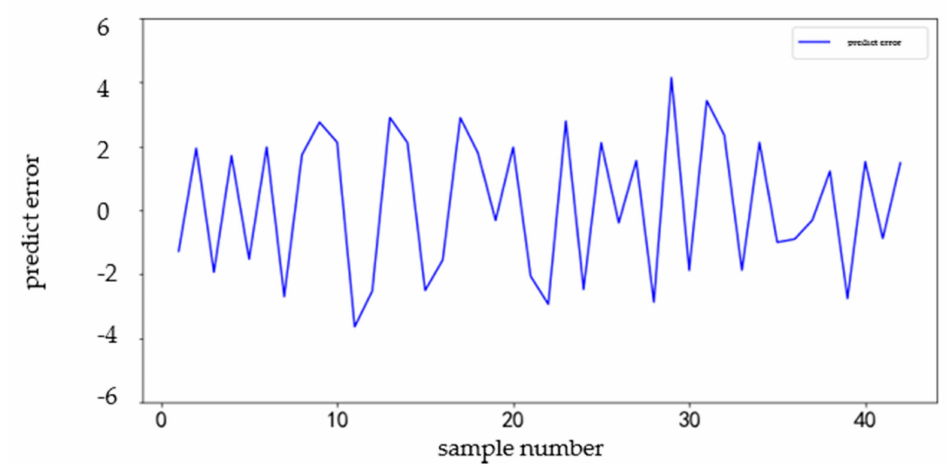
Figure 12. Prediction comparison chart of station collection 1.